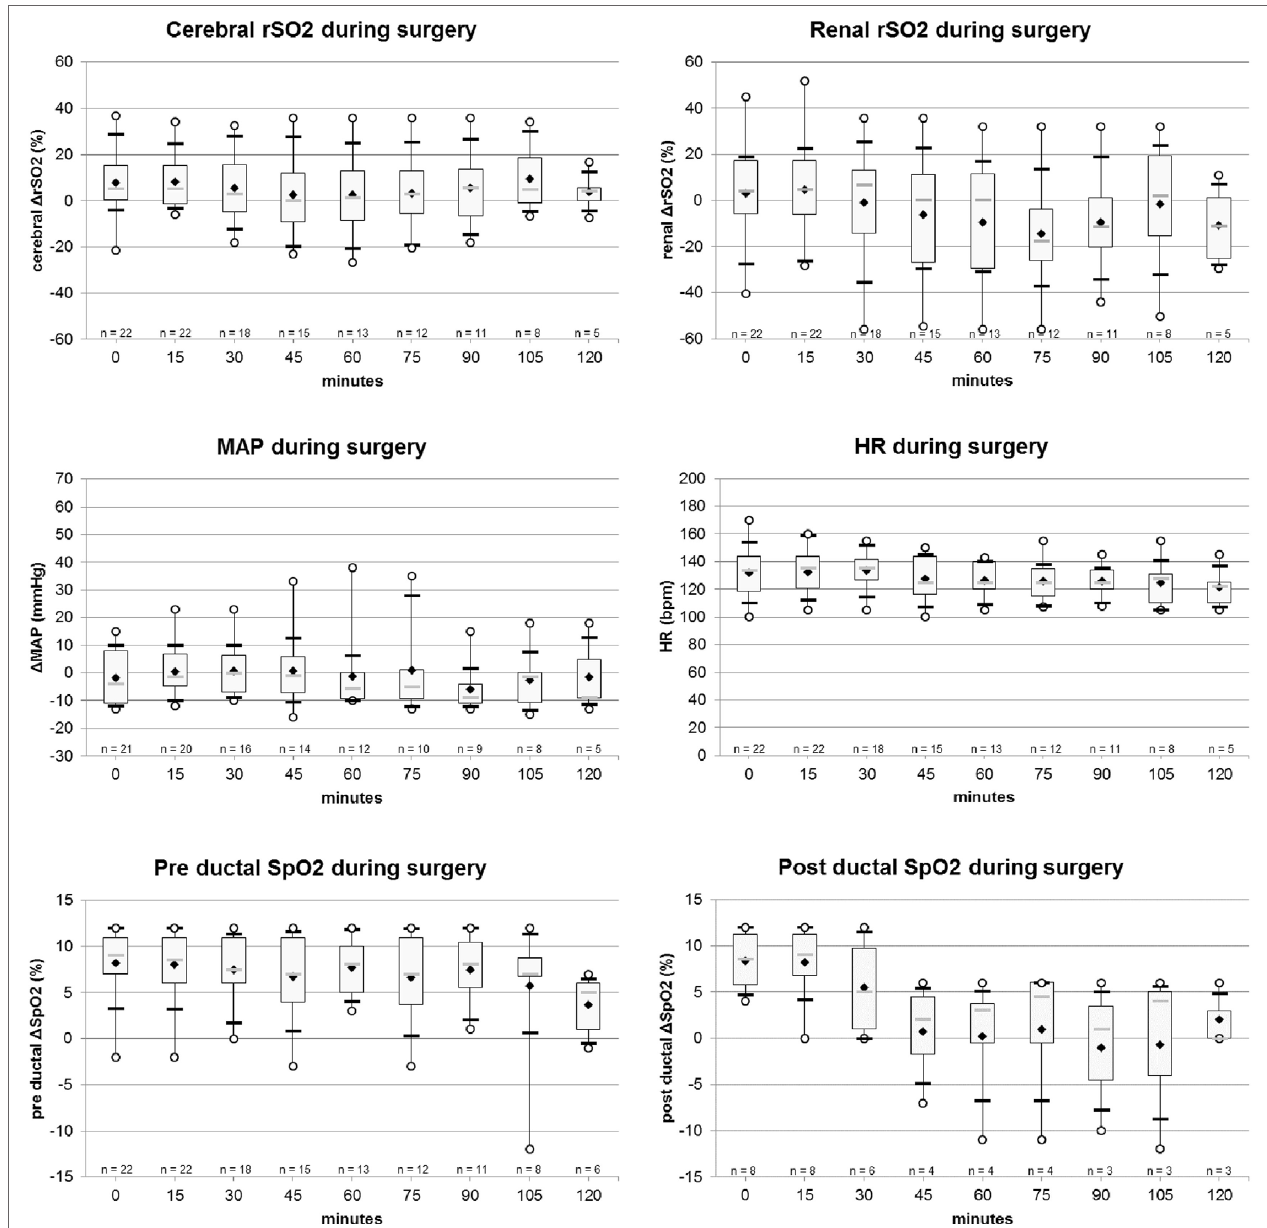
FigUre 1 | Evolution of cerebral and renal rSO 2 (%), mean arterial pressure (MAP) (mmHg), heart rate (HR) (bpm), pre and post-ductal SpO 2 values, during surgery. Legend: ⚪ , minimum and maximum; — , first and ninth decile; gray — , median; white ▮ , quartile 25 and quartile 75; ⬥ ,